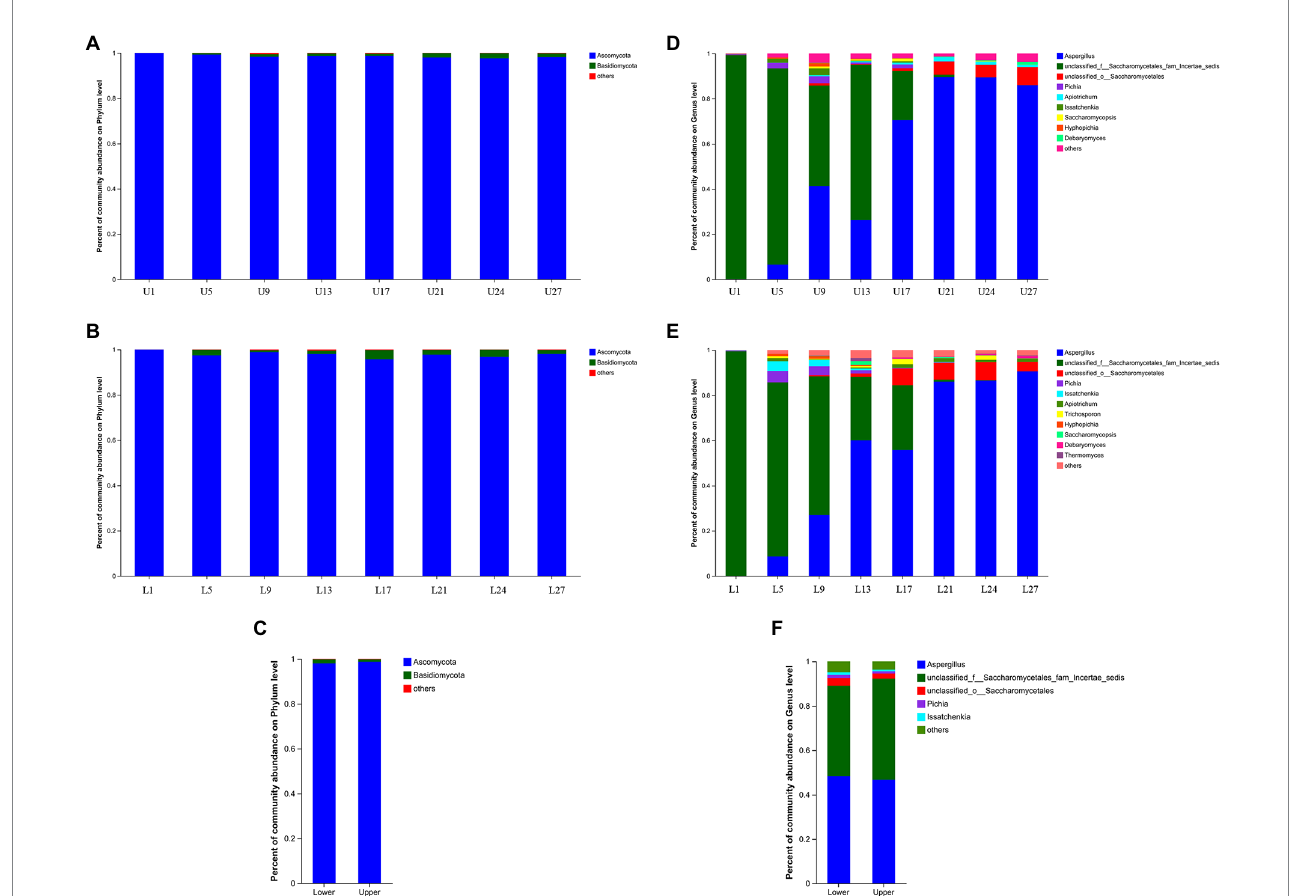
FIGURE 3 Relative abundance of the fungal community structure. (A) The upper layer at phylum level, (B) the lower layer at phylum level, (C) the upper and lower layers at phylum level, (D) the upper layer at genus level, (E) the lower layer at genus level, (F) the upper and lower layers at genus